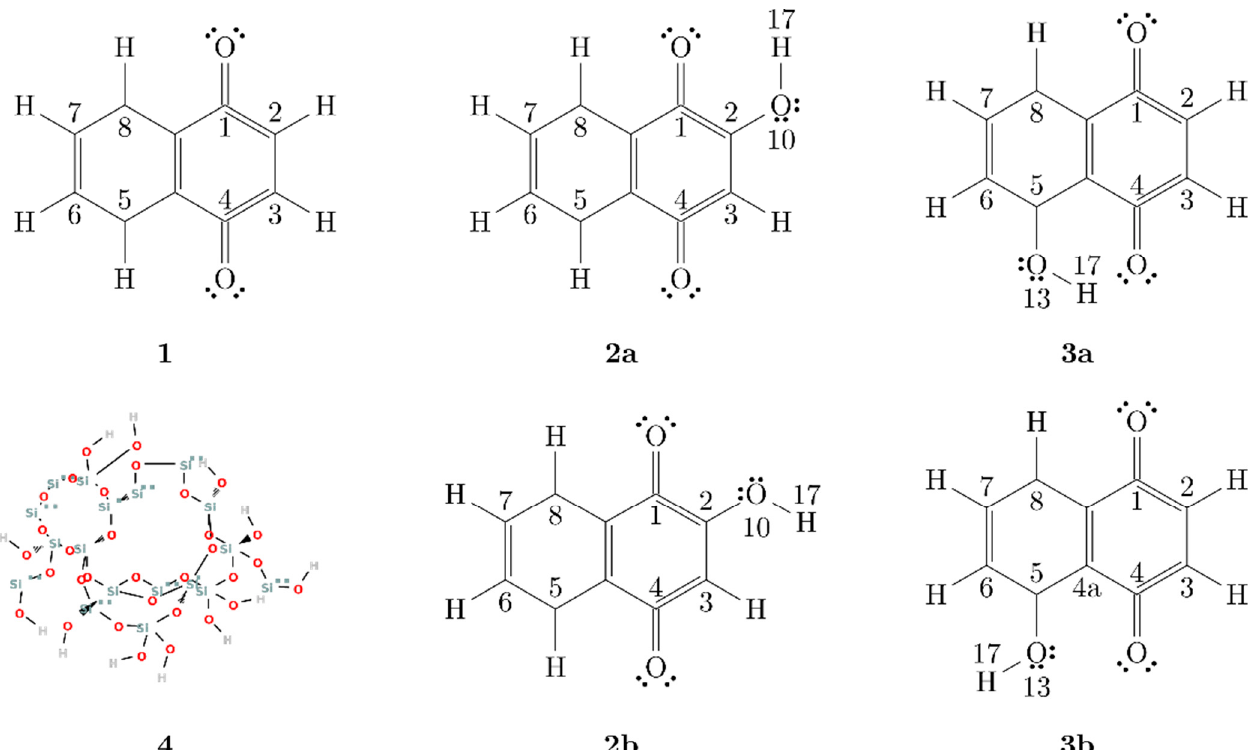
Figure 6. Structure of NQ derivatives and SiO 2 molecules. ( 1 ) NQ; ( 2a ) closed and ( 2b ) open configuration of 2NQ; ( 3a ) closed and ( 3b ) open configuration of 5NQ; ( 4 ) SiO 2 molecular model.